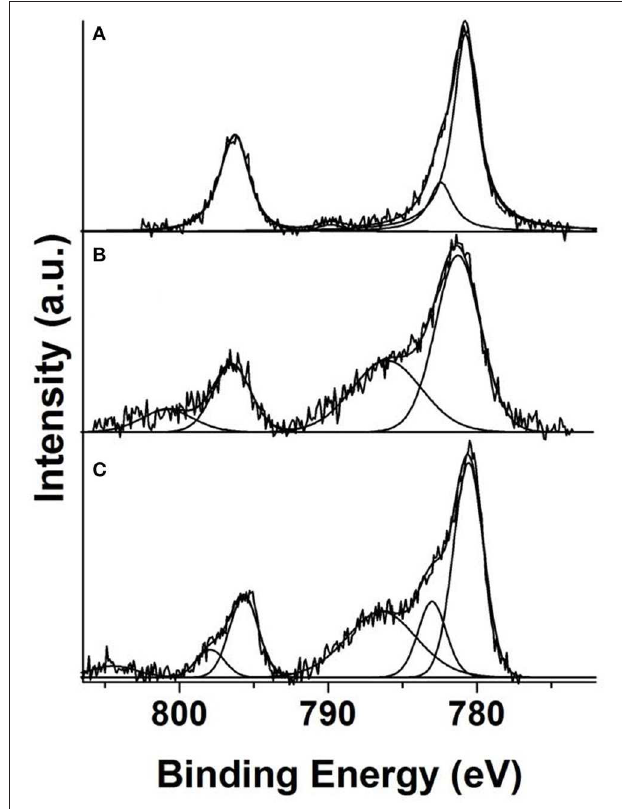
FIGURE 3 | Deconvoluted Co 2p XPS spectra recorded from powder samples of (A) 8(2-Et-C 6 H 11 O)CoPc-Py-CNT, (B) CoPc-Py-CNT, (C)